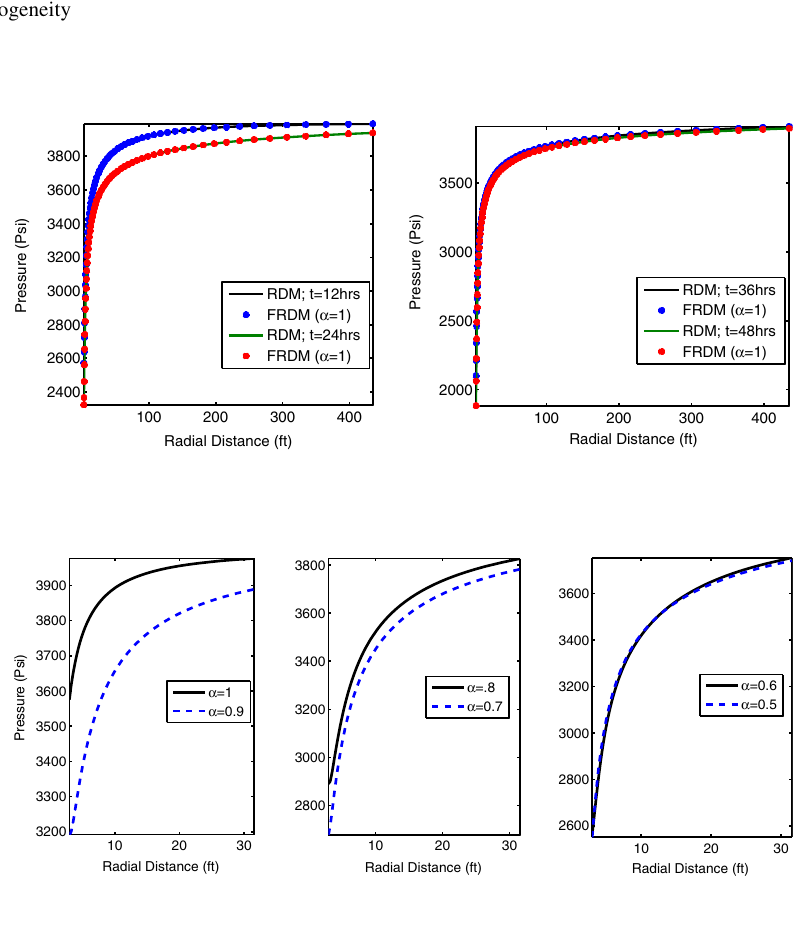
Fig. 2 Effect of the variation of the level of heterogeneity